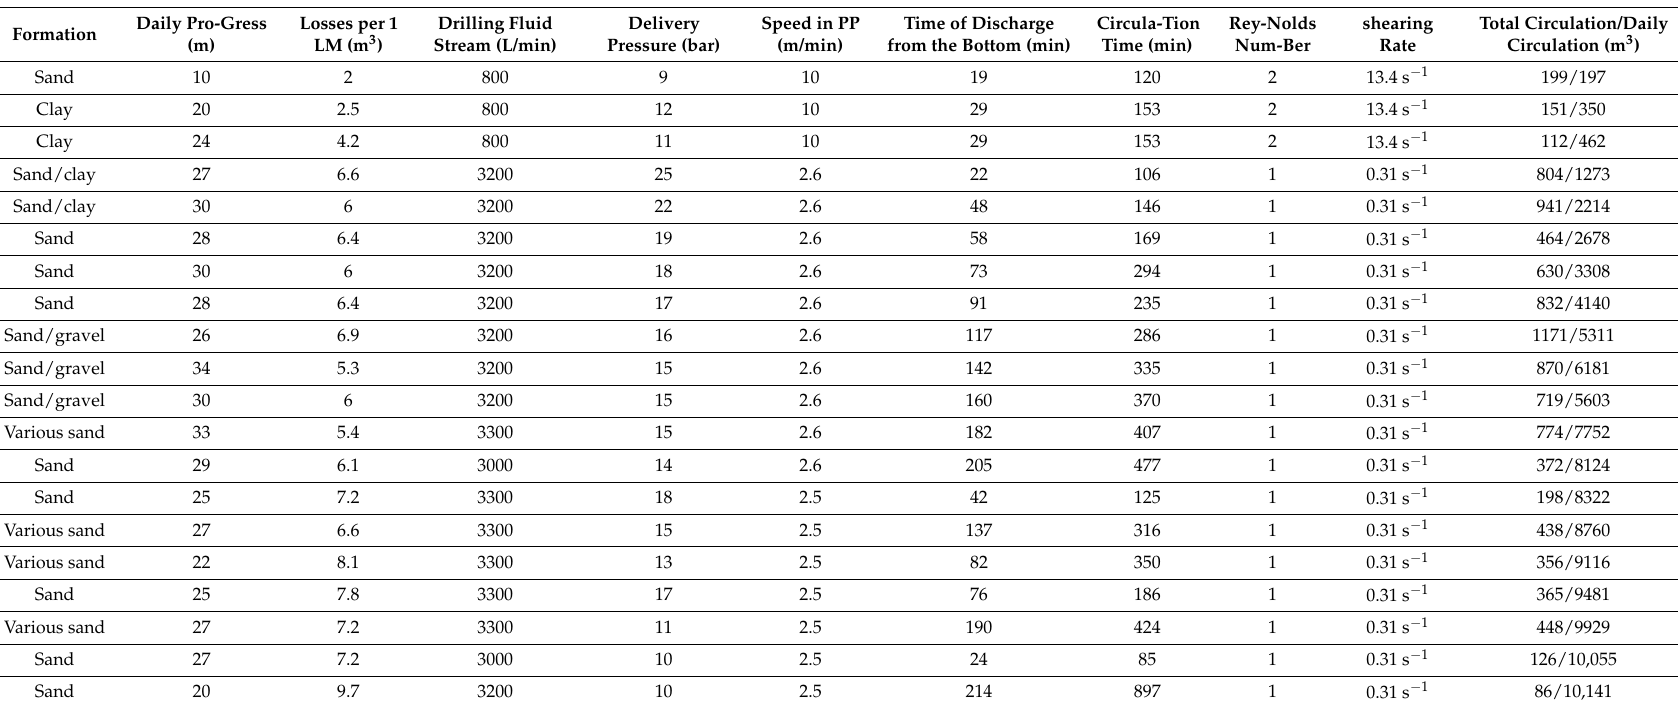
Table 4. Daily losses of drilling fluid and basic circulation data in the P˛ecisz ó w facility (directional drilling